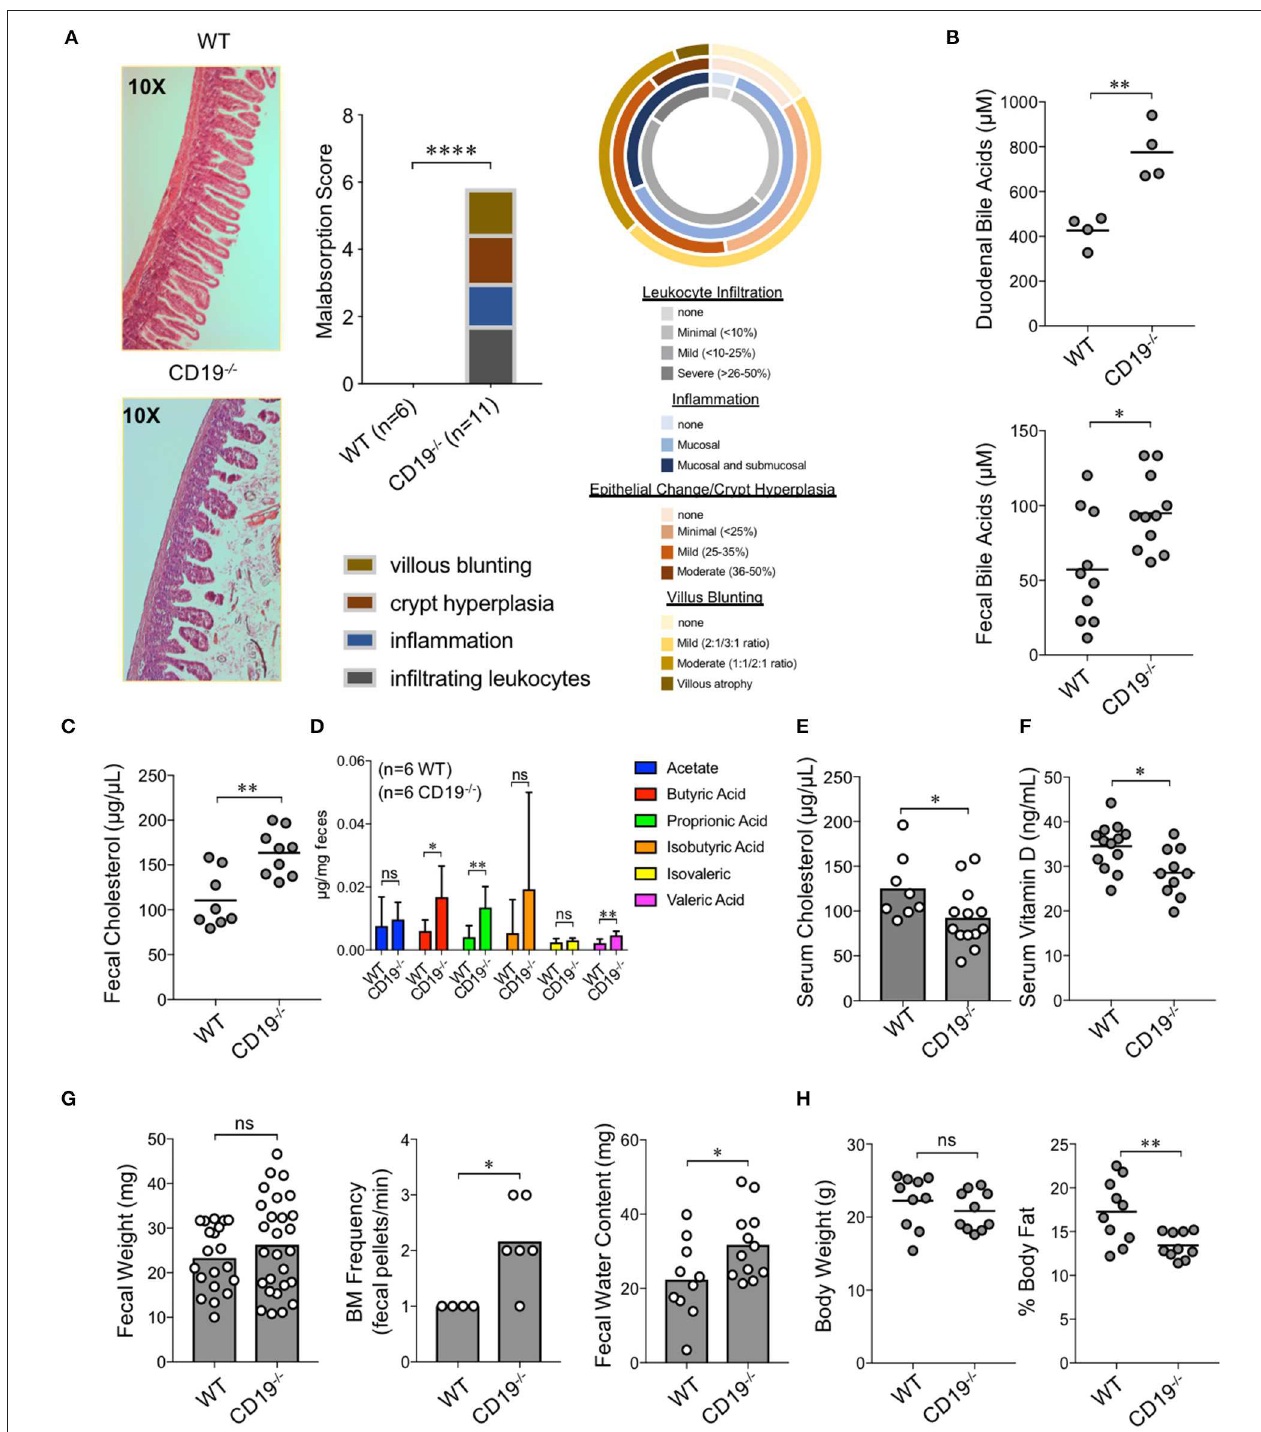
FIGURE 3 | Gut IgA deficiency is associated with intestinal malabsorption in CD19 − / − mice. (A) H&E histological analysis of ileum from WT and CD19 − / − mice using a 4-point malabsorption scoring index. Circle plot represents the percentage of CD19 − / − animals falling into the respective score grouping. Colors represent severity (darker means more severe and the size of colors per circle represent percentage of animals in that category). (B) Total duodenal and fecal BA concentrations are shown. (C) Total fecal cholesterol levels are shown. (D) Fecal SCFA concentrations are shown. (E) Serum cholesterol titers are shown. (F) Serum vitamin D titers are shown. (G) Fecal weight, defecation frequency, and fecal water content are shown. (H) Body weight and results of DEXA scan of fat mass are shown. (B–G) Student’s t -test; * = p < 0.05, ** = p < 0.01. Error bars in D represent S.D. (A) Result of Two-way ANOVA (row factor = genotype), **** = p < 0.0001.